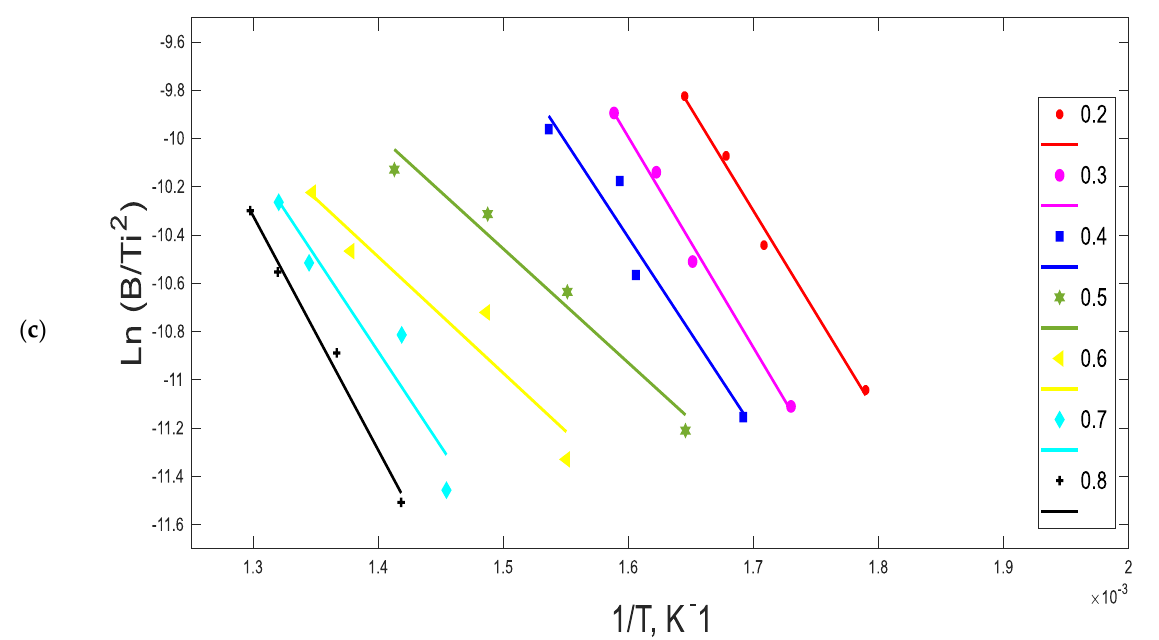
Figure 5. KAS diagrams of pyrolysis ( a ), gasification ( b ), and combustion ( c ) of Subcoal™ PAF for given values of conversion at heating rates of 5, 10, 15, and 20 °C/min. Table 7. Kinetic parameters obtained by KAS Table 6. Kinetic parameters obtained by OFW method.